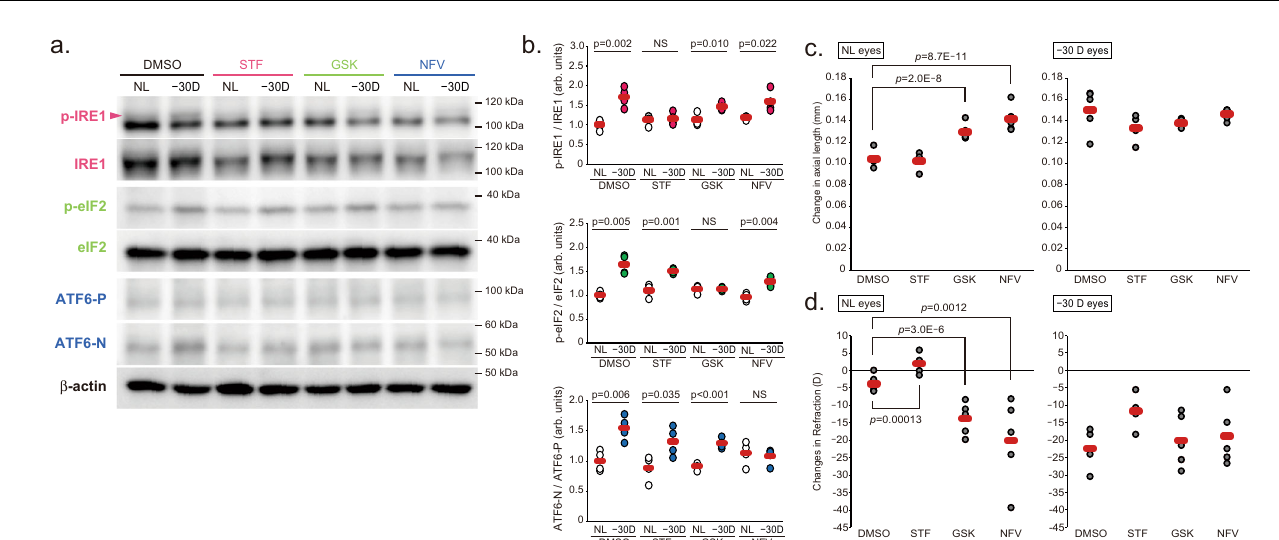
Fig. 3 | InductionofscleralER stressresultsin the development ofmyopia. a A single tunicamycin (Tm; 50 µ g/mL) instillation induces acute IRE1, eIF2, and ATF6 activation (1hour after instillation) determined by Western blotting ( n =4, each sample pooled 3 sclerae). b A single Tm (50 µ g/mL) instillation induces acute ER stress, evaluated as CHOP mRNA expression by qPCR ( n =4 per group). DMSO group in each time point were assigned a value of 1.0. * p <0.05 compared to each